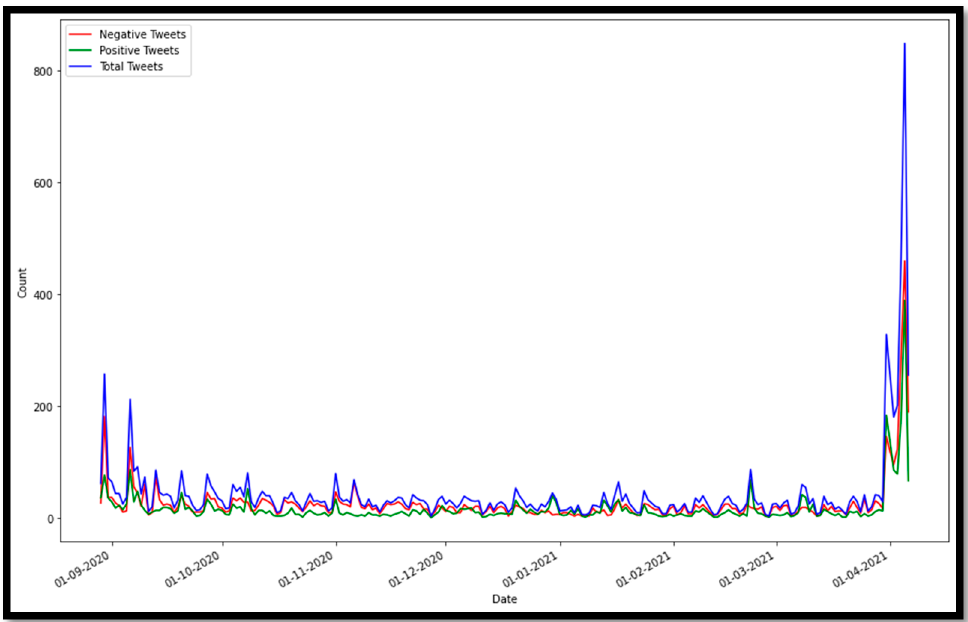
Figure 10. Top 20 Frequent words from the intermediate and high schools’ positive tweets.